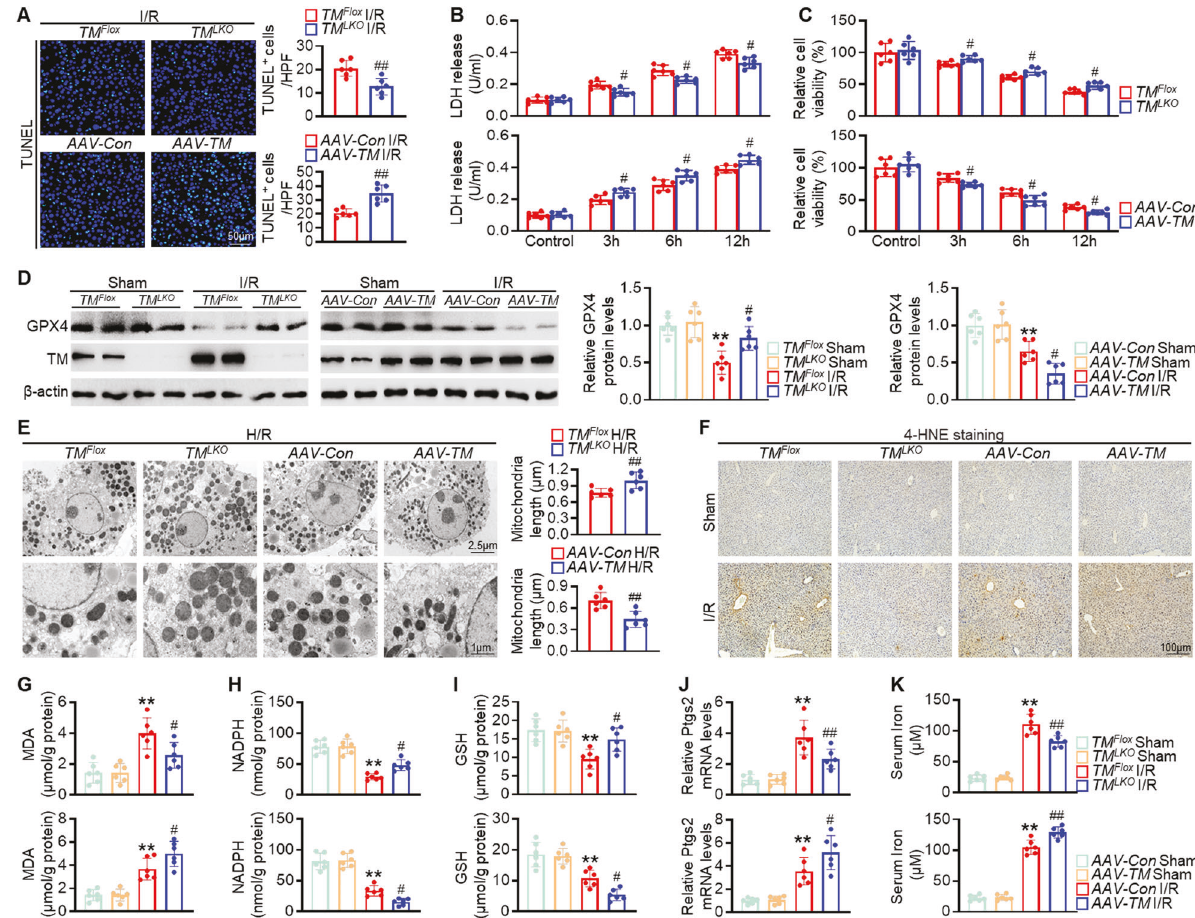
Fig. 4 TMEM16A deletion protects against hepatic I/R-induced ferroptosis. A Representative TUNEL immuno fl uorescence staining and quanti fi cation of TUNEL-positive cells in liver sections from TM Flox , TM LKO , AAV-Con -treated, and AAV-TM -treated mice subjected to 90 min of hepatic ischemia followed by 24 h of reperfusion ( n = 6). ## P < 0.01 versus TM Flox I/R or AAV-Con I/R. B LDH release and C CCK-8 assay results of hepatocytes isolated from TM LKO mice or AAV-TM -treated mice and their counterpart control mice subjected to 4 h of hypoxia followed